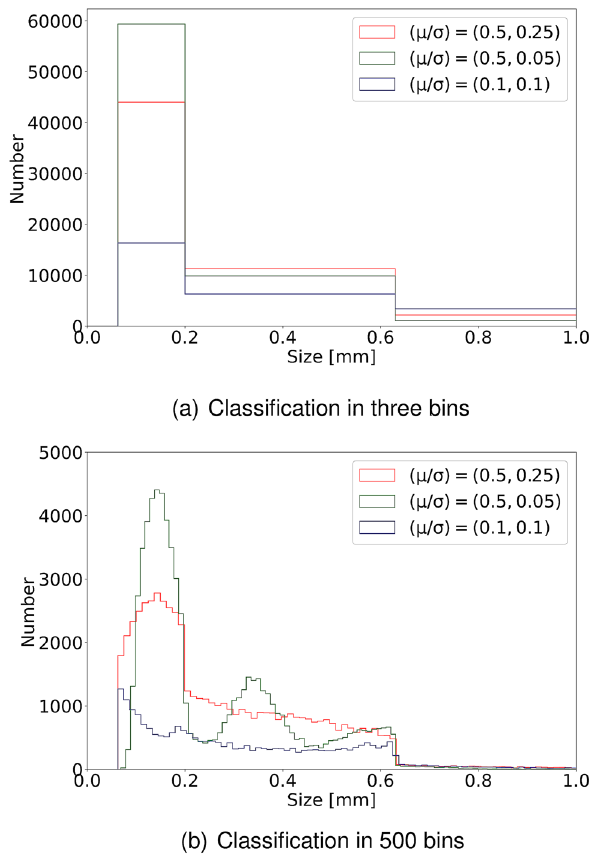
Figure 1. Size distributions projected into three bins ( a ) and 500 bins ( b ) as calculated from our simulations ˜ (cid:31) = 0.65 with and variations of (µ/σ) . Asymmetric decays [for (µ , σ) = ( 0.1, 0.05 ) , blue line] lead to a flatter and more uniform distribution. Symmetric decays with strong variations [for (µ , σ) = ( 0.5, 0.25 ) , red line] show a high peak located at smaller particle sizes. Symmetric decays with little variation [ (µ , σ) = ( 0.5, 0.05 ) , green line] give the highest peak for small particles and show three distinct peaks of particle